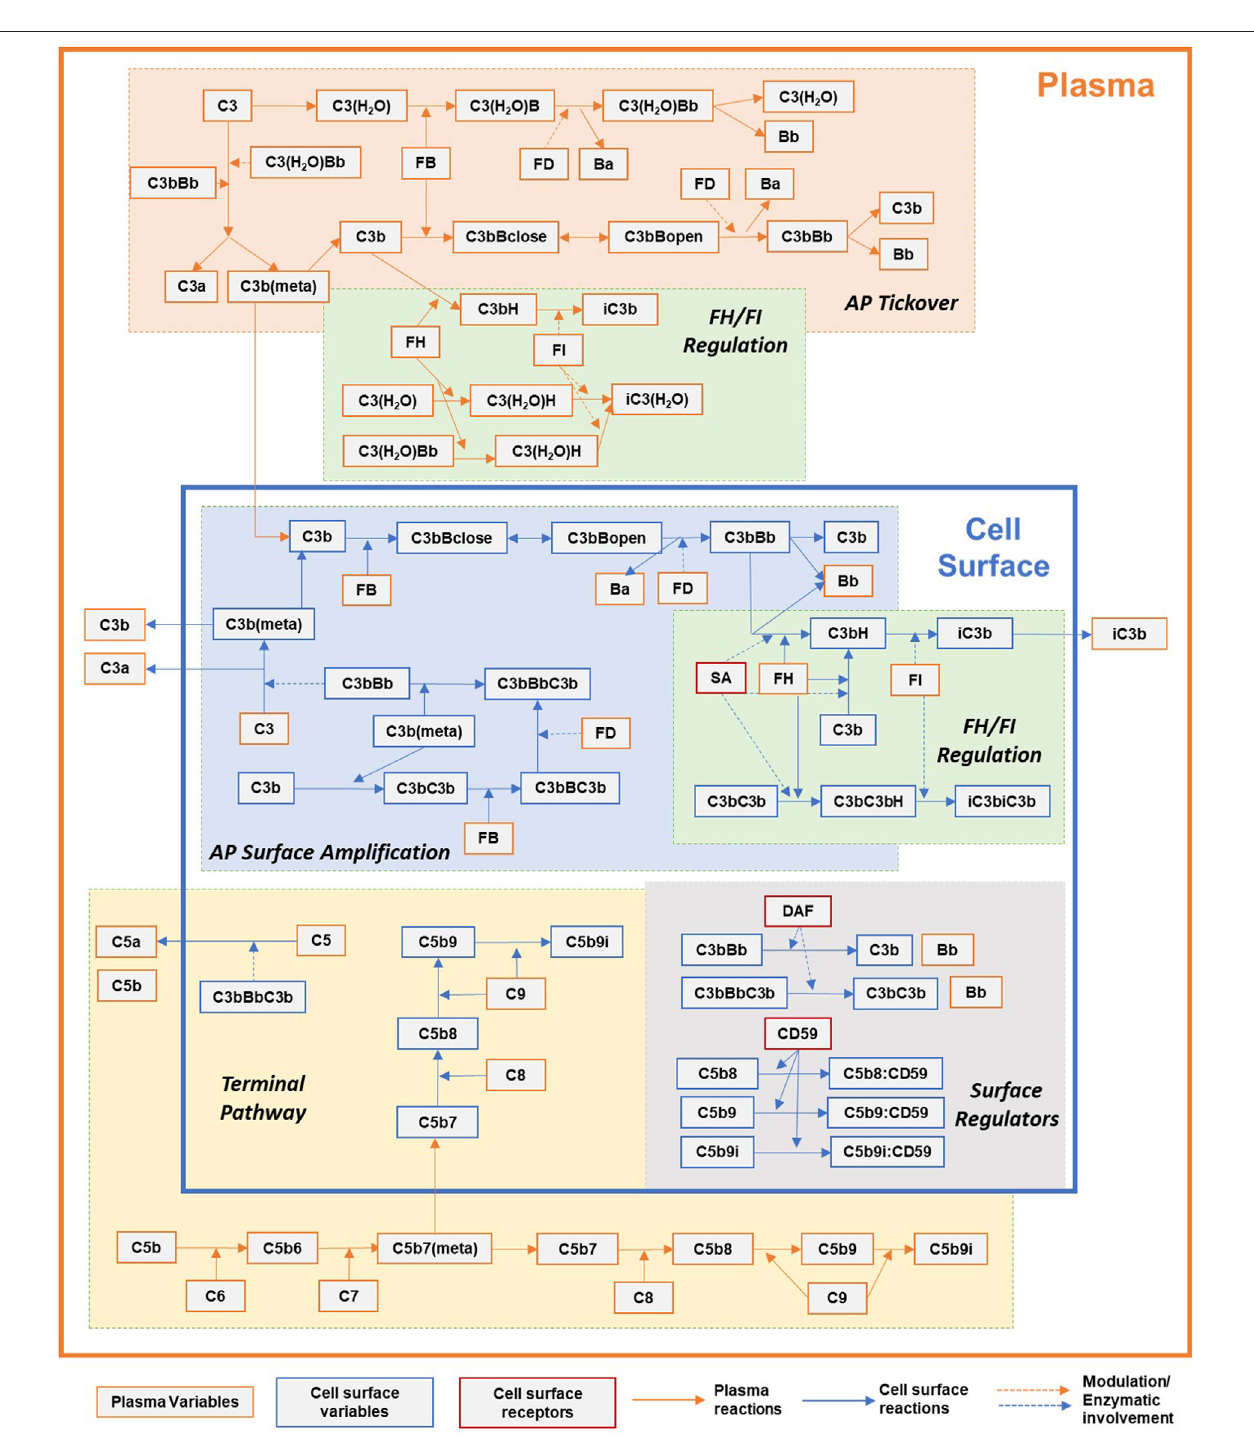
FIGURE 1 | Simpli fi ed overview of the processes in the complement pathway model for plasma and cell surface reactions. Key processes shown here: alternative pathway(AP)tickover,regulationbyFHandFIinplasmaandcellsurface,APsurfaceampli fi cation,terminalpathway,andsurfaceregulators:sialicacid,DAF,andCD59. Dynamics for binding of complement proteins to Properdin are not included here for simplicity and represented separately in Figure 2 . Other key processes included in the model but not shown here: dynamics of regulation by CR1, clusterin, and vitronectin.